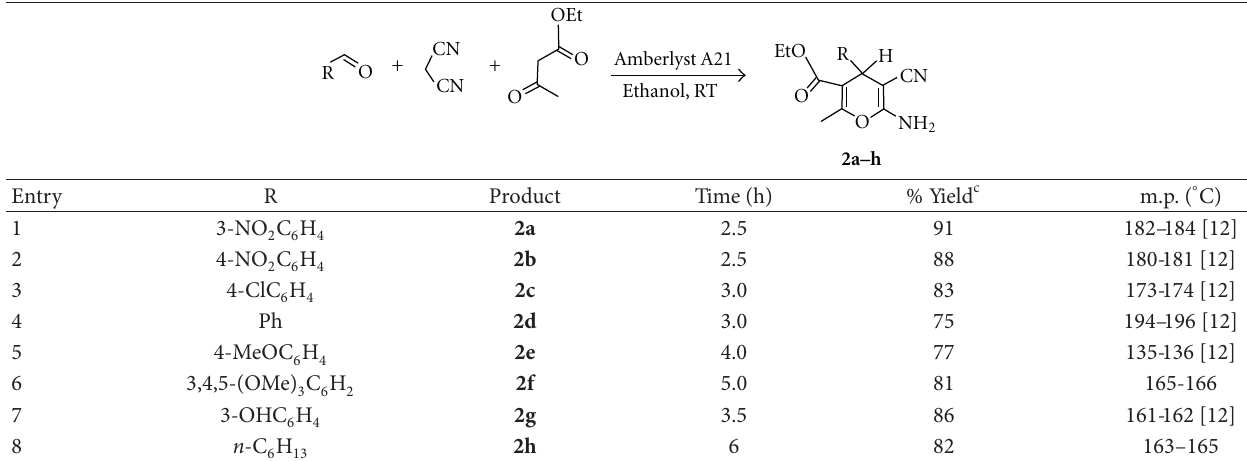
T 4: Synthesis of substituted pyrans from ethyl acetoacetate via Scheme 1. a,b